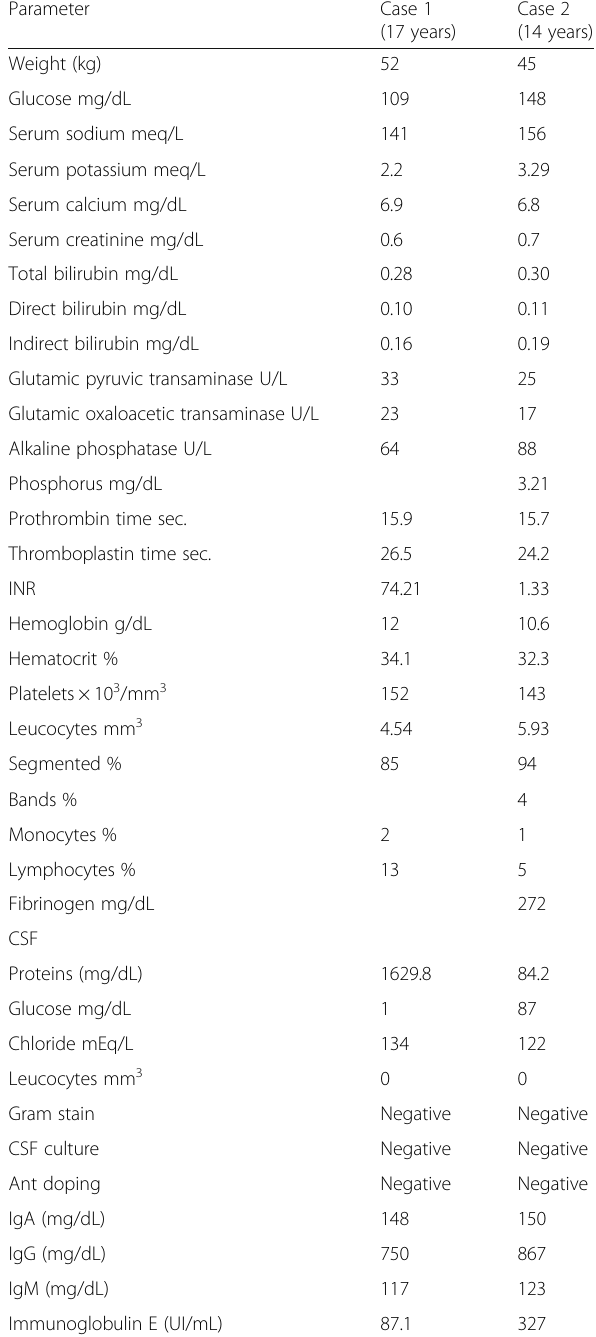
Table 1 Laboratory tests reported in the patients